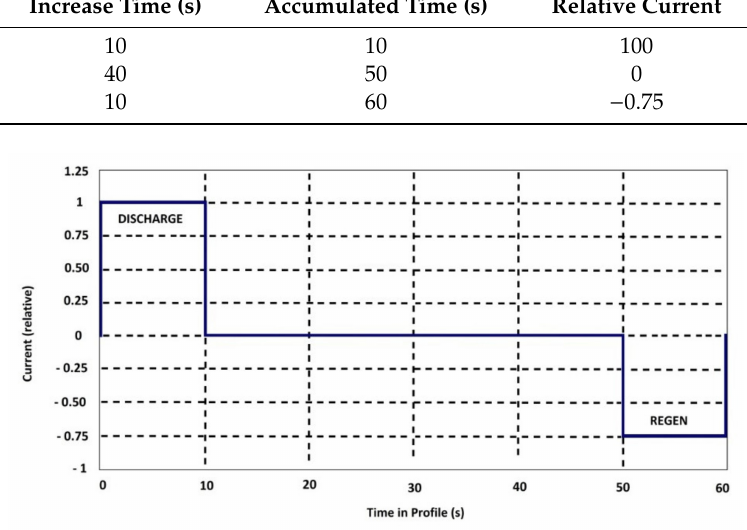
Figure 21. Profile of the HPPC